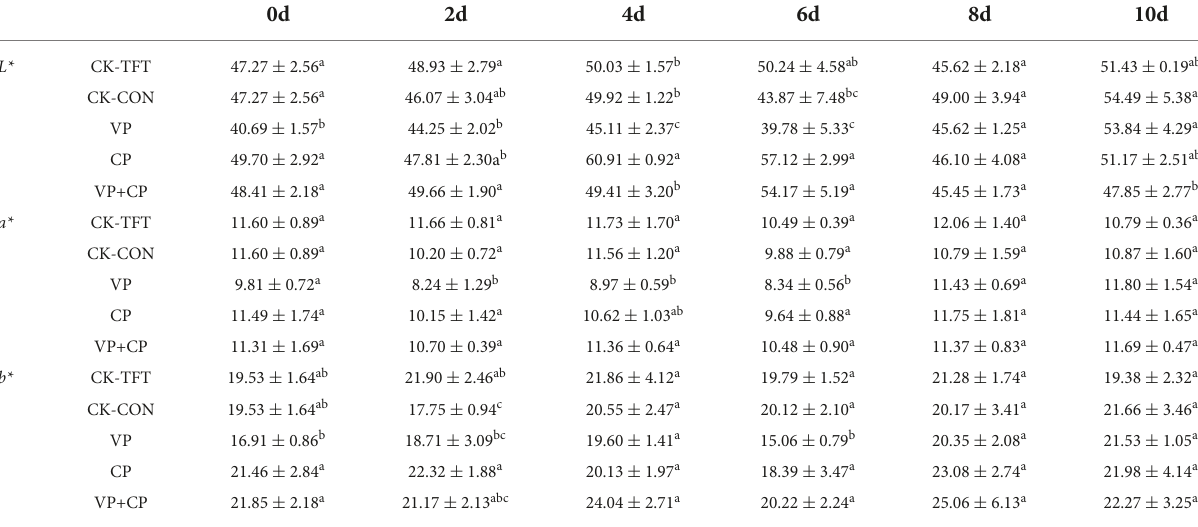
TABLE 1 Effects of different treatments on L* , a* , and b* of salmon in cold chain